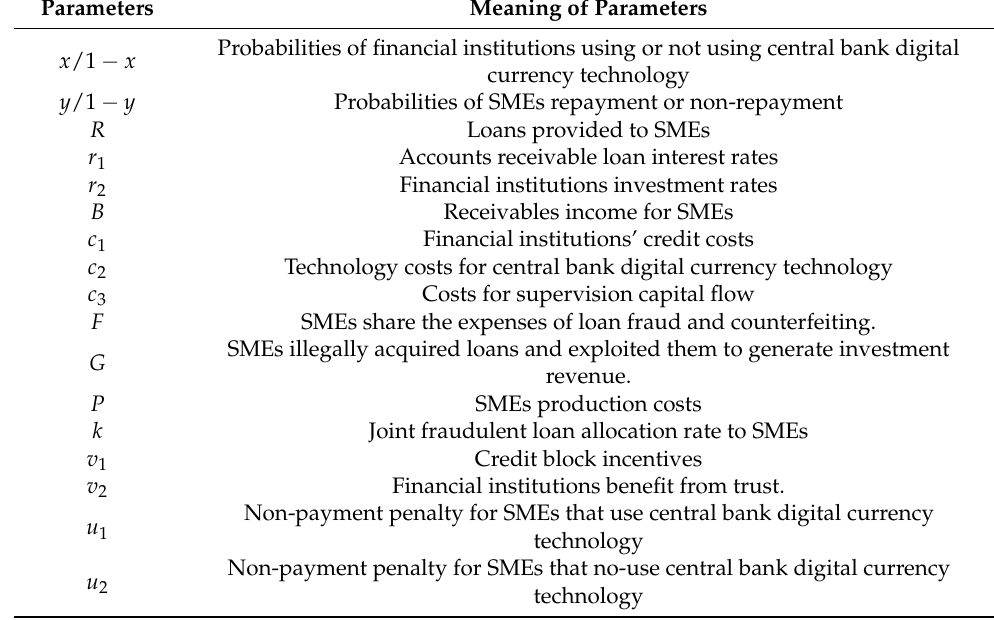
Table 1. Basic parameters